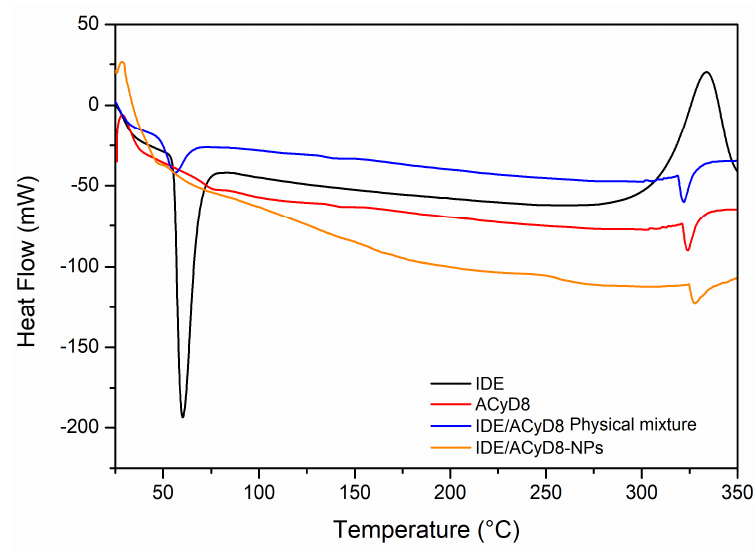
Figure 12. DSC traces of IDE/ACyD8-NPs (sample C), pure IDE and ACyD8, and the physical mixture.